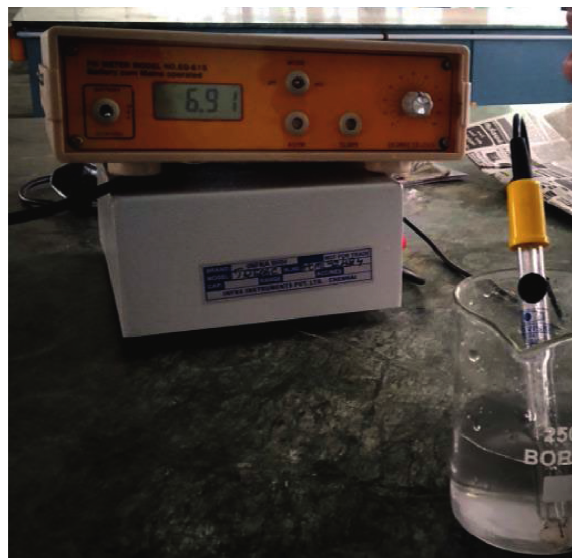
Figure 13: pH value after second